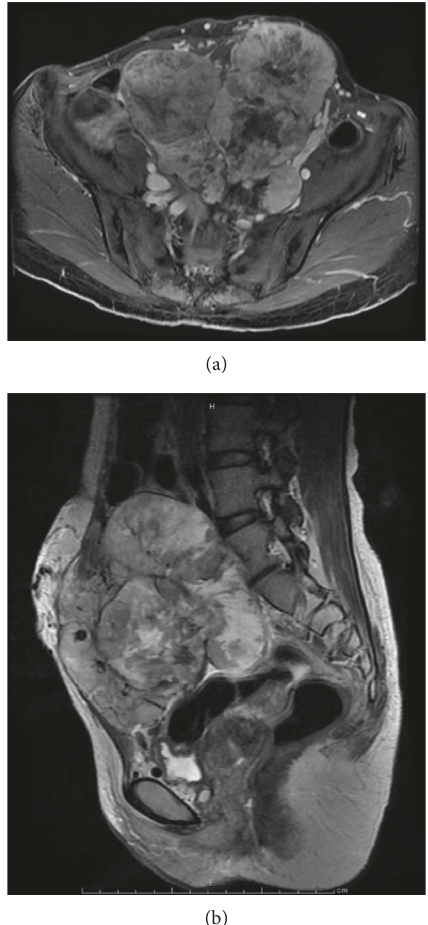
Figure 1: Magnetic resonance imaging findings at the initial visit. (a) T1-weighted fat suppression gadolinium-enhanced image (axial view). (b) T1-weighted fat suppression gadolinium-enhanced im- age (sagittal view). This MRI showed a large lobulated lesion with strong enhancement. The tumor was located at the abdominal wall, bulging to the lumbar spine.